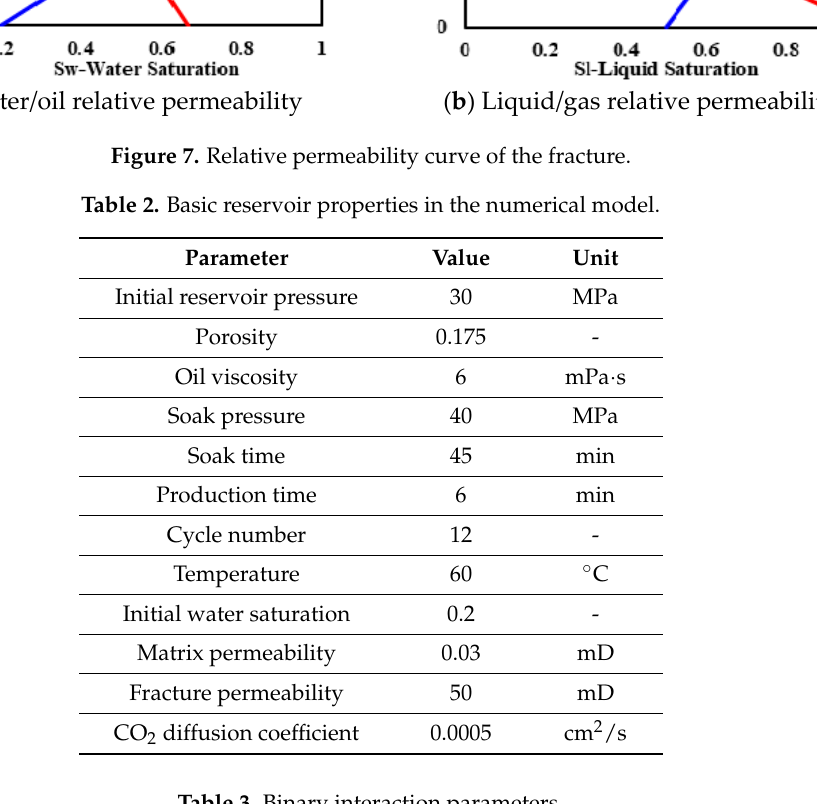
Table 3. Binary interaction